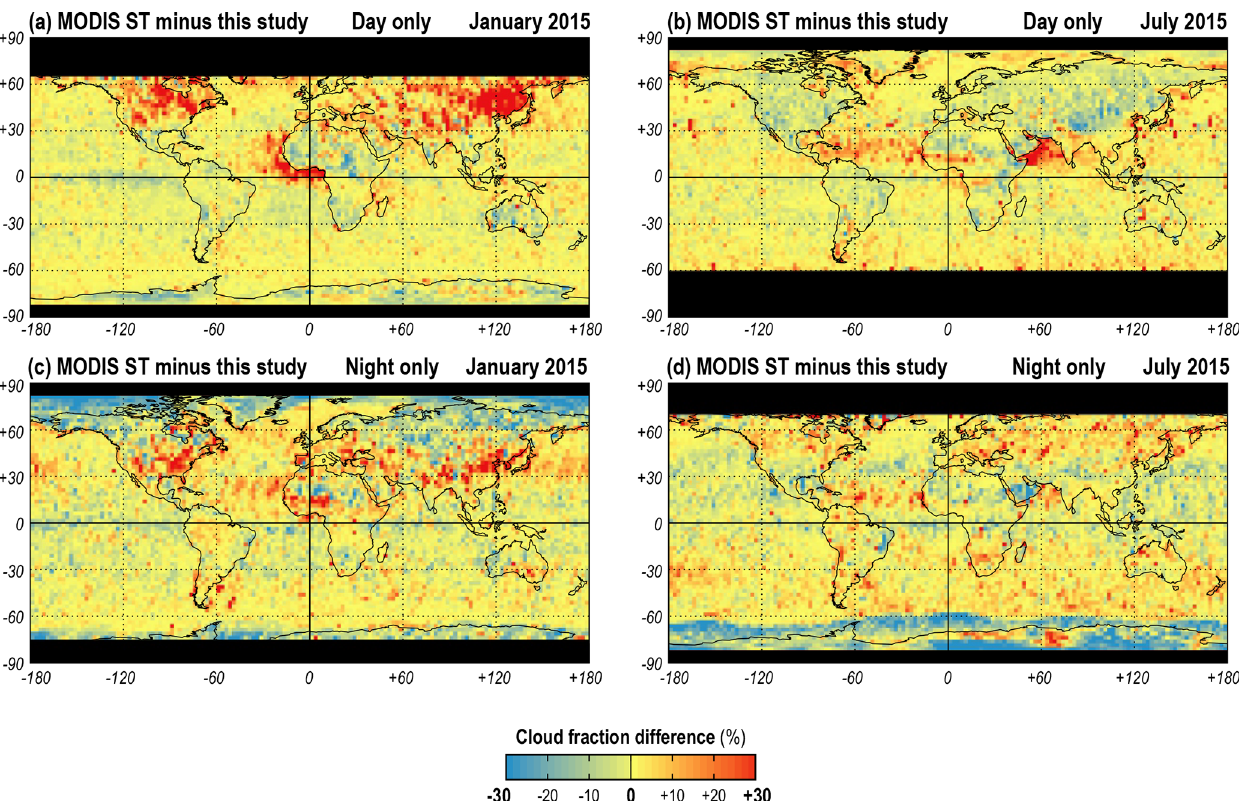
Figure 8. Difference between the MODIS Science Team (MODIS ST) Level 3 cloud amount product and cloud amount calculated with the cloud fractions found in this study. Positive values indicate that the MODIS operational product overestimates cloud amount (with respect to CALIOP), while negative values indicate a MODIS underestimate. All MODIS observations refer to the full swath, not only those collocated with